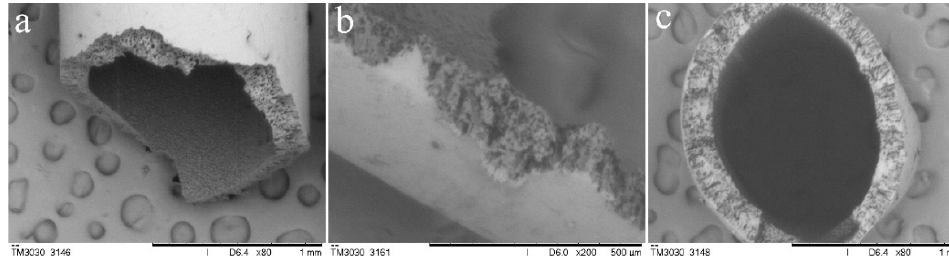
Figure 1. SEM cross-section morphology of hollow PVDF fibers: ( a ) the cross-section of a fiber with uniform thickness, ( b ) mall cavities in the fiber wall material with an average diameter of 1 μ m, and ( c ) a fiber deformed after compression with a certain amount of mechanical strength.